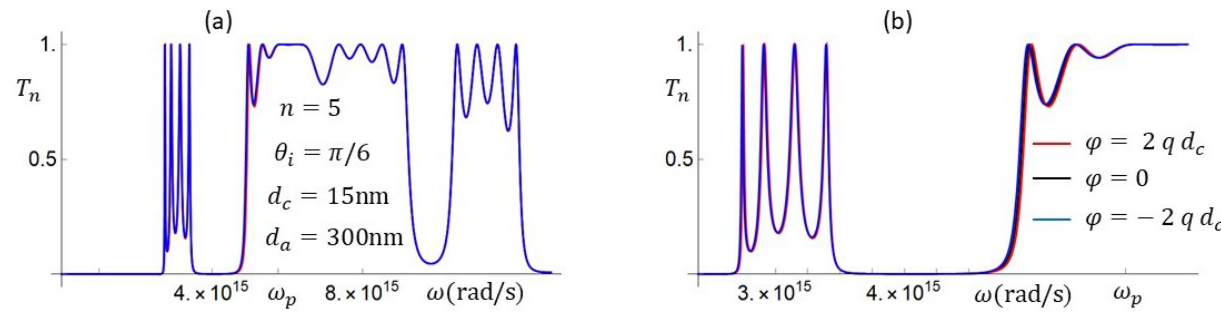
Figure 15. Transmission coefficients as functions of d a and θ i plotted here to compare with those in Figures 10a and 12b. The agreement is perfect.